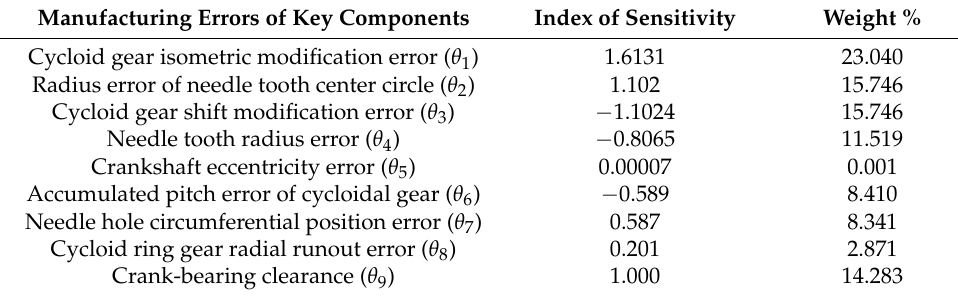
Table 1. Sensitivity index of manufacturing errors of key components. Manufacturing Errors of Key